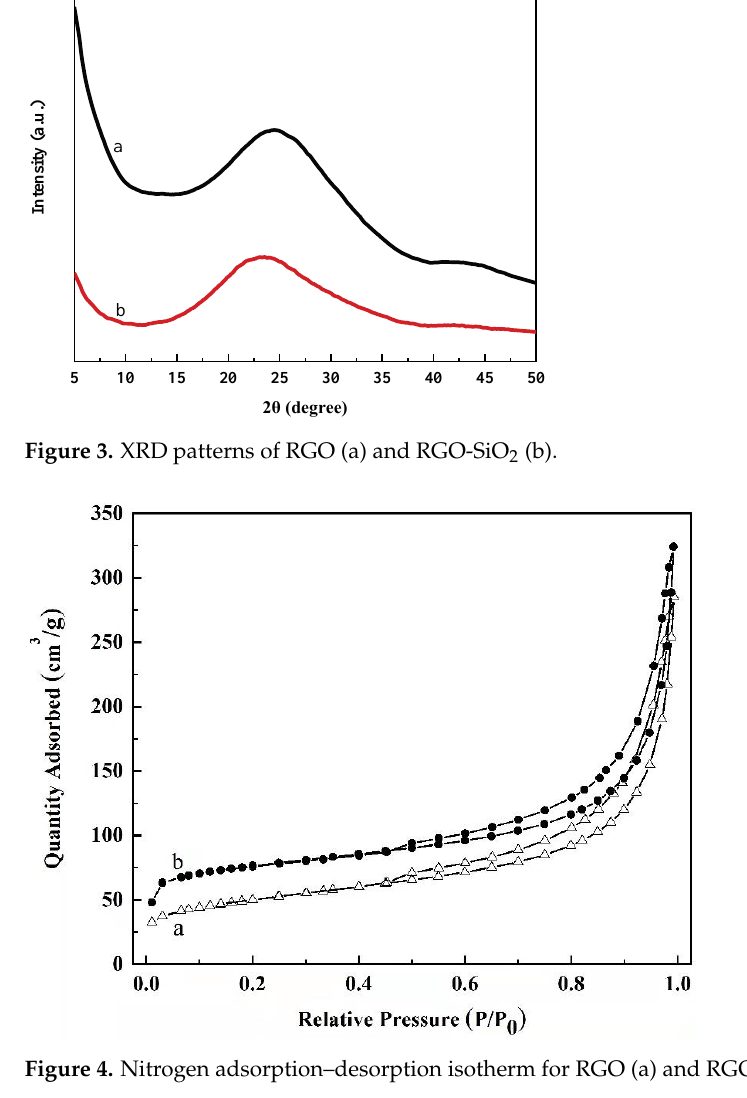
Figure 3. XRD patterns of RGO (a) and RGO-SiO 2 (b).